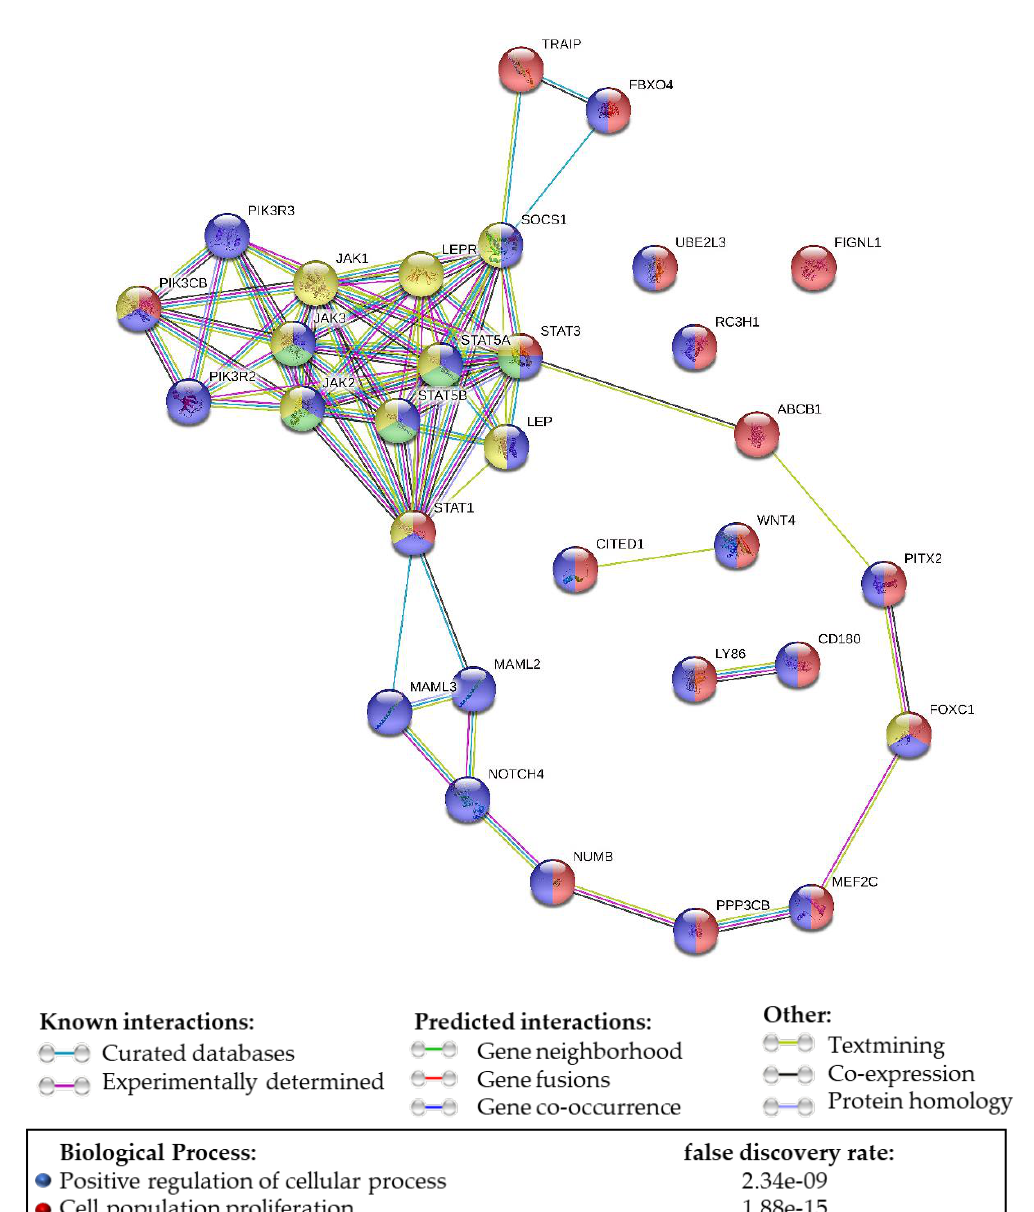
Figure 9. Leptin-induced protein–protein interaction (PPI) network in triple-negative breast cancer cells. PPI analysis of proteins from 18 genes (circles) that were up- or downregulated in MDA-MB231 cells following 24 h treatment with leptin (6.25 nM) created using STRING (online version 11.0) [40]. The lines connecting the proteins depict “known” or “predicted” interactions. Statistical analysis of the whole genome was calculated with STRING (online version 11.0) [40]. The PPI network enrichment p -value = 1.1 × 10 − 12 , indicating that these interations within the network are significant. A total of 73 edges (protein–protein relationships) were discovered from 28 edges expected. Differentially expressed genes (DEGs) were determined by Log FC >1.4 and p ≤ 0.05 .